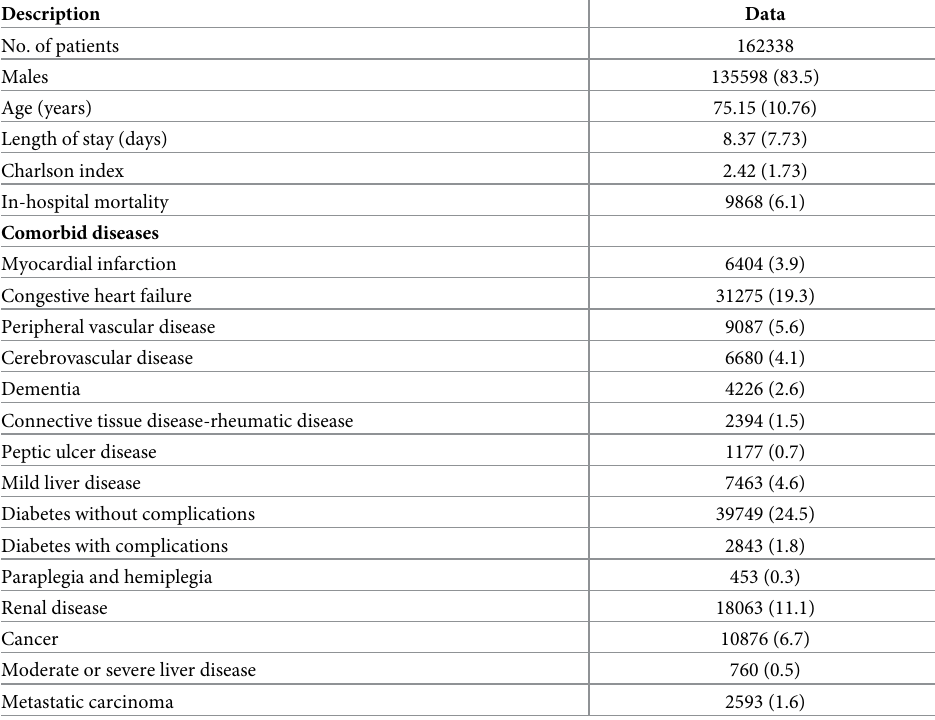
Table 1. Epidemiological and clinical characteristics of patients admitted to hospital with a COPD exacerbation in Spain from 2004 to